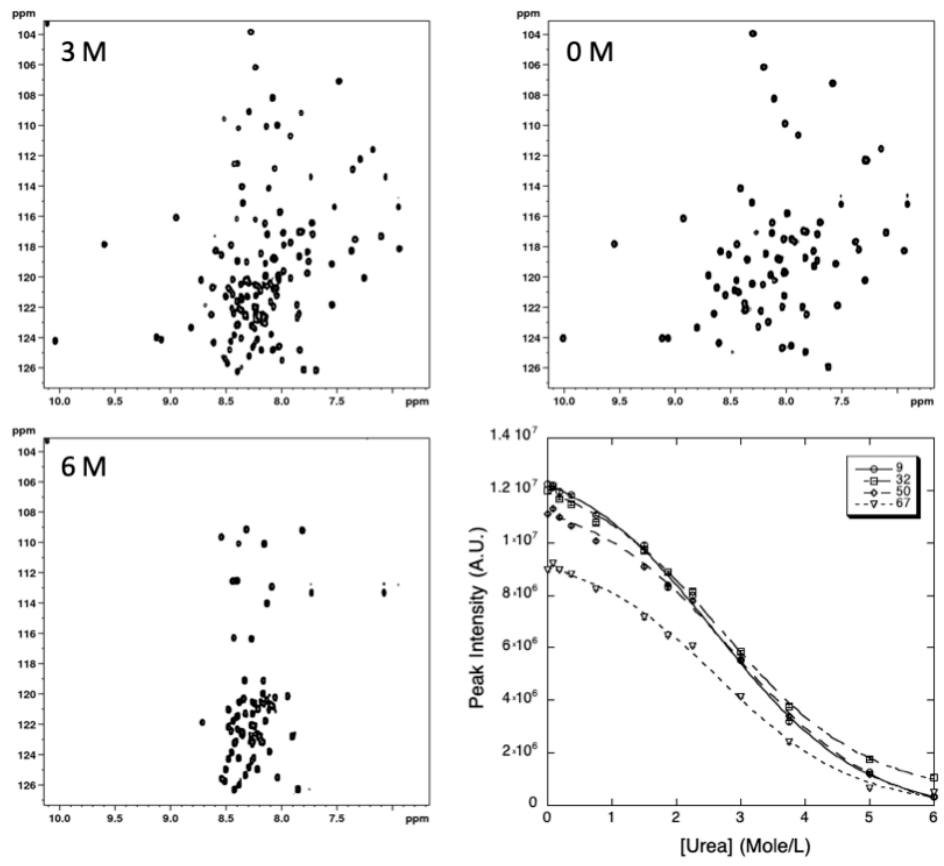
Figure 7. NMR detected chemical unfolding of GIPC1-GH2 at 20 °C. Examples of [ 1 H, 15 N] HSQC at 0, 3, and 6 M urea are displayed. The last panel shows an overlay of four (residues K9, T32, L50, and V67) residue-specific denaturation curves obtained from the fits of the urea concentration-dependent sigmoidal decrease of the corresponding residue cross-peak intensities in the HSQC spectra with Equation (5).